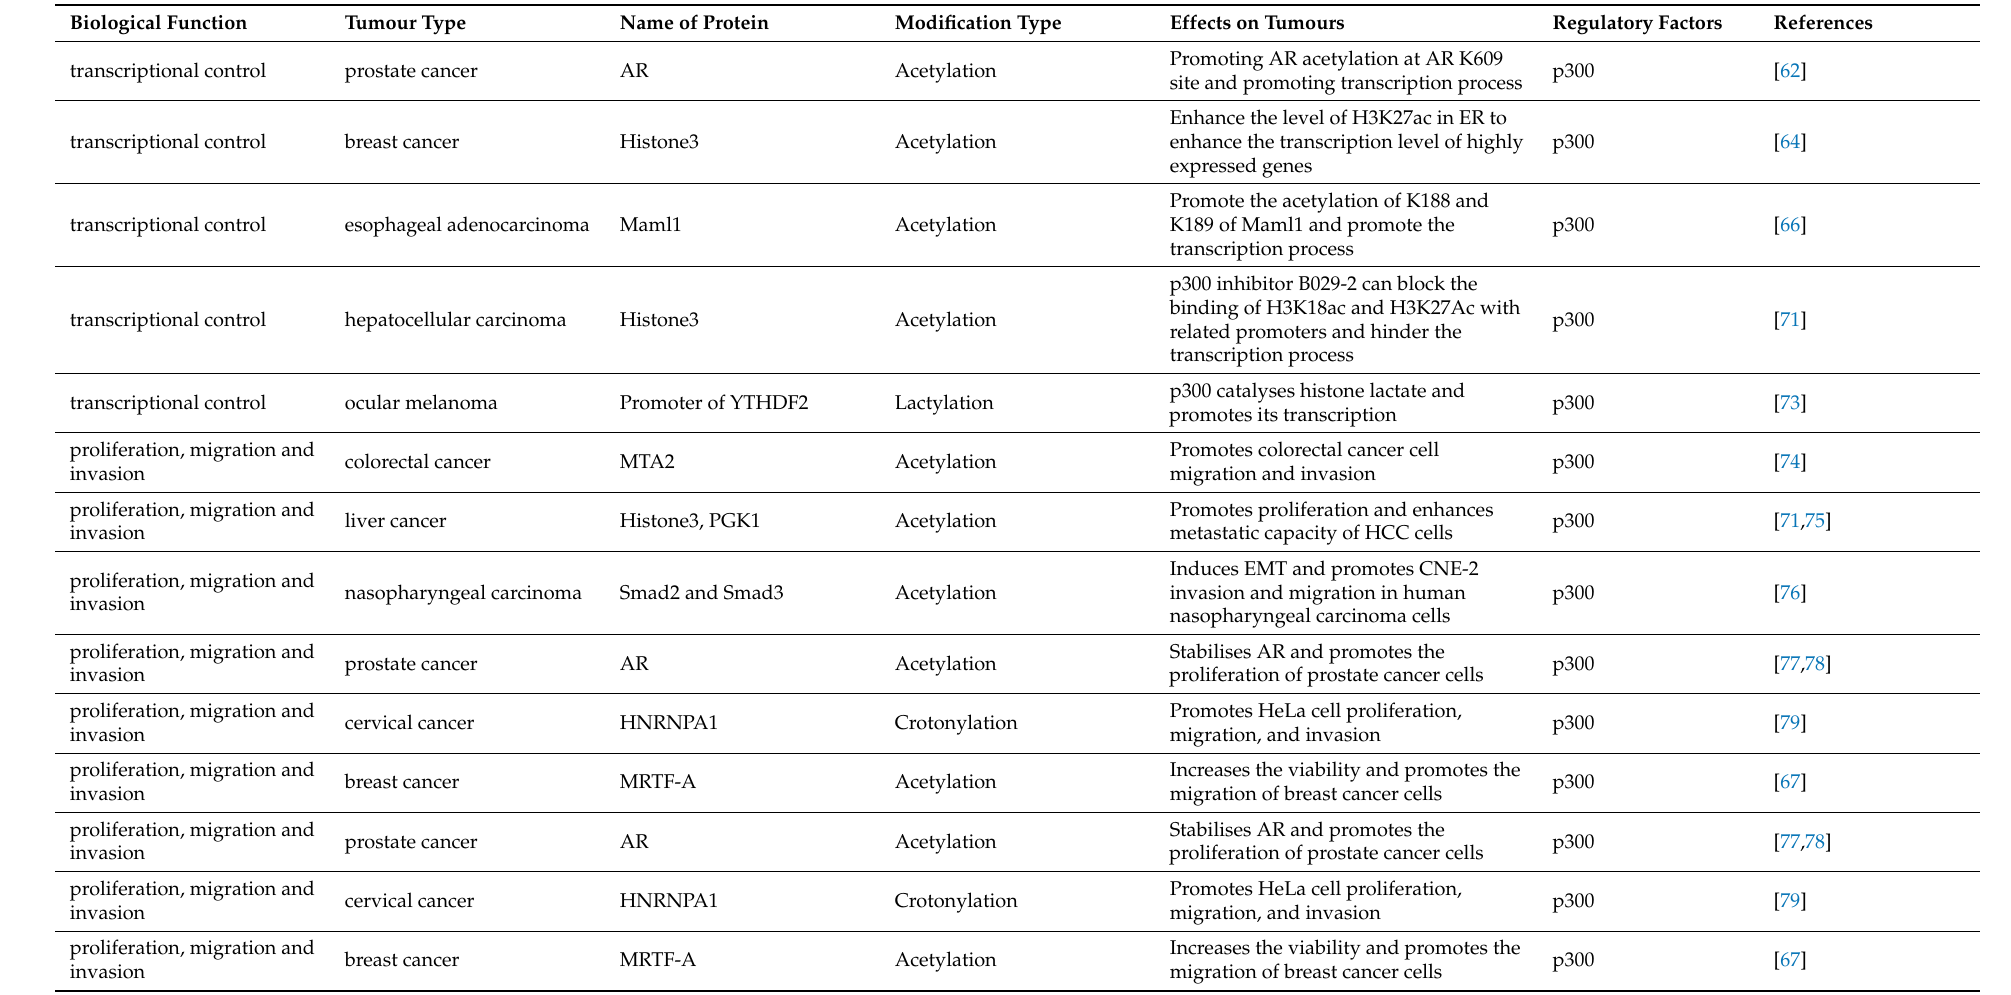
Table 2. Summary of the role of p300-mediated posttranslational modification in tumours biological